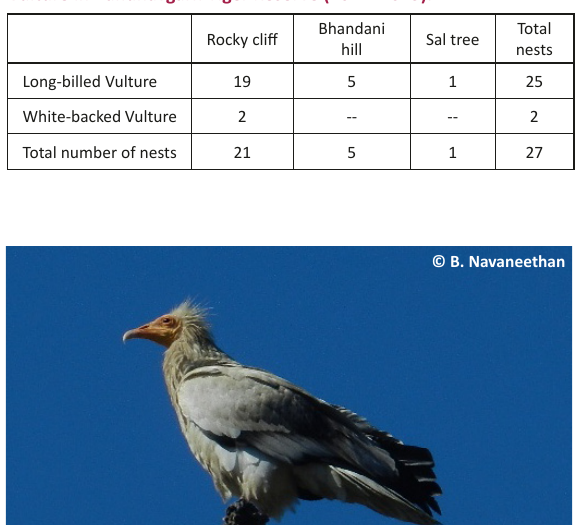
Table 2. Associations among different species of vultures observed in Bandhavgarh National Park (2011–2013).